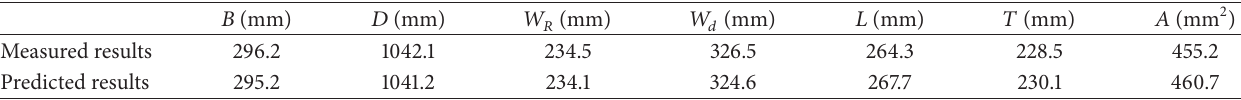
𝐿 and 𝑇 , and the area of tire footprint 𝐴 .)